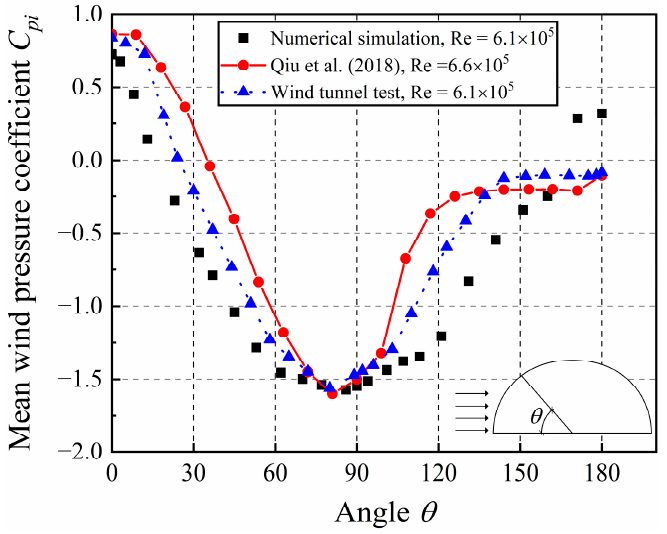
Figure 14. Comparison of the mean pressure coefficients along centerline of the model [41].